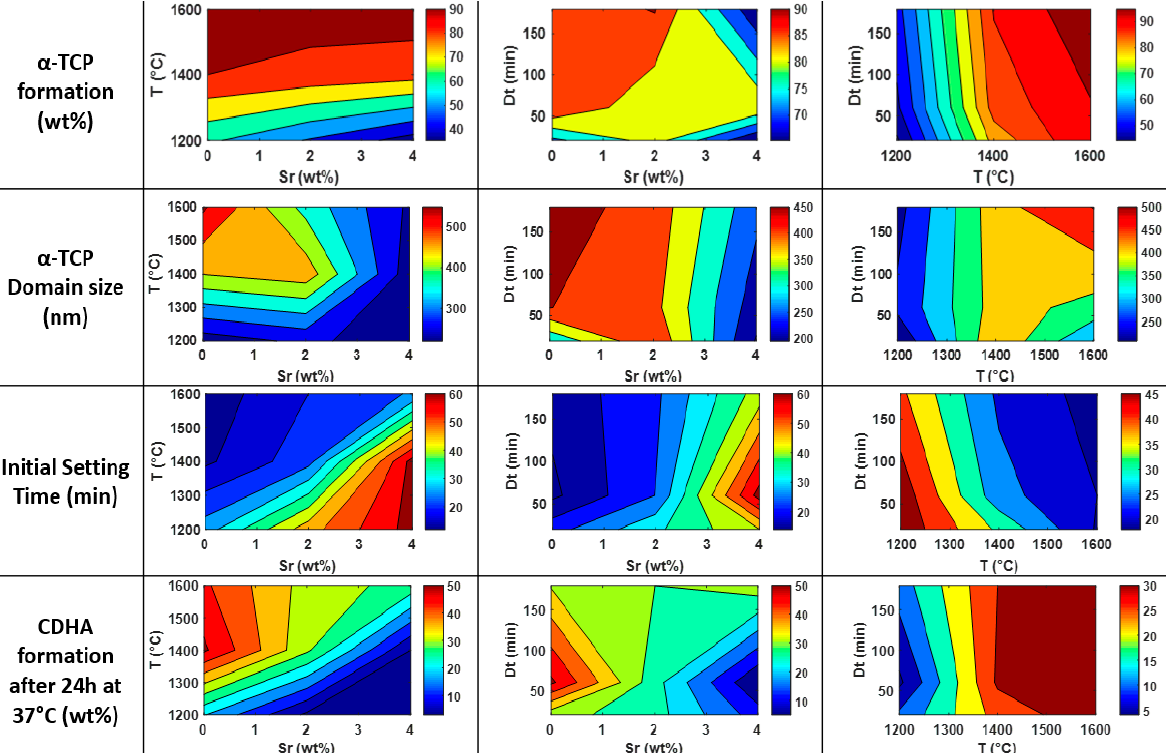
Figure 1. Contour plots related to the Powder Thermal Treatment scheme: The effect of strontium amount (Sr), temperature (T), and dwell time (Dt) on the α -tricalcium phosphate ( α -TCP) formation (first row), α -TCP domain size (second row), initial setting time (third row), and calcium-deficient hydroxyapatite (CDHA) formation (forth row). The output variables are represented, as reported in the colored scale bars, from blue (lower values) to red (higher values).